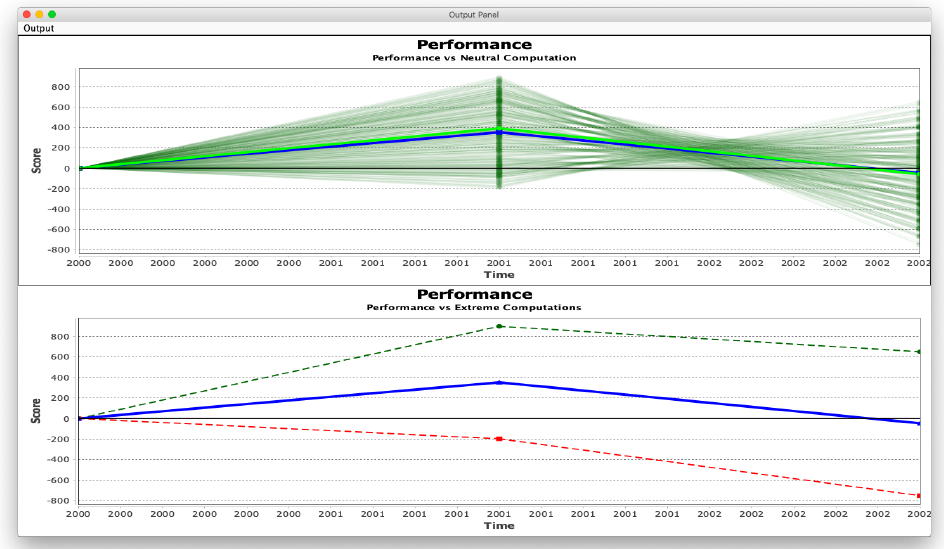
Figure 4. GUI—output.